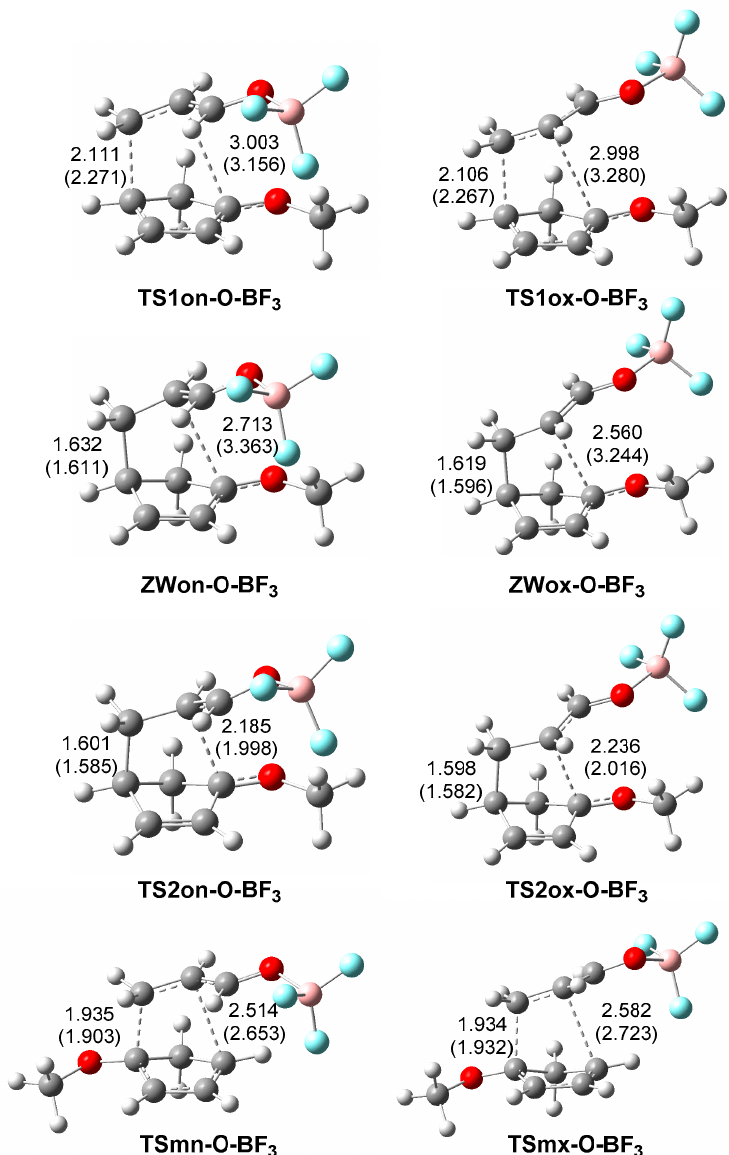
Figure 7. B3LYP / 6-311G(d,p) gas phase and in dichloromethane (DCM) geometries of the regio and stereoisomeric TSs and intermediates involved in the P-DA reaction of Cp 13 with complex 7-BF 3 . Distances are given in angstroms, Å. Distances in DCM are given parenthesis.